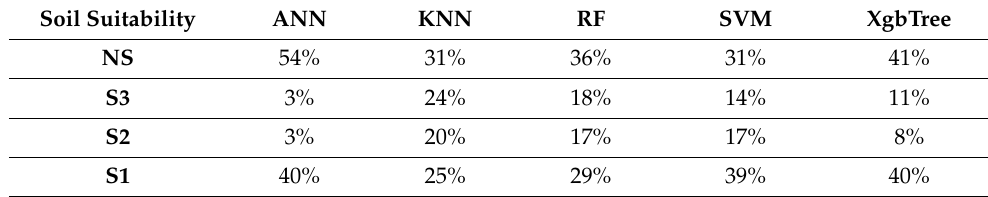
Table 3. The percentage of suitability classes in the five models.